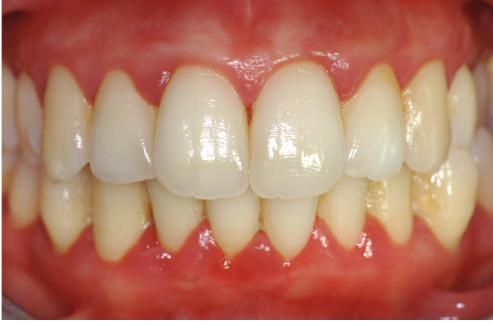
Figure 4: Frontal view of clinical situation at baseline.